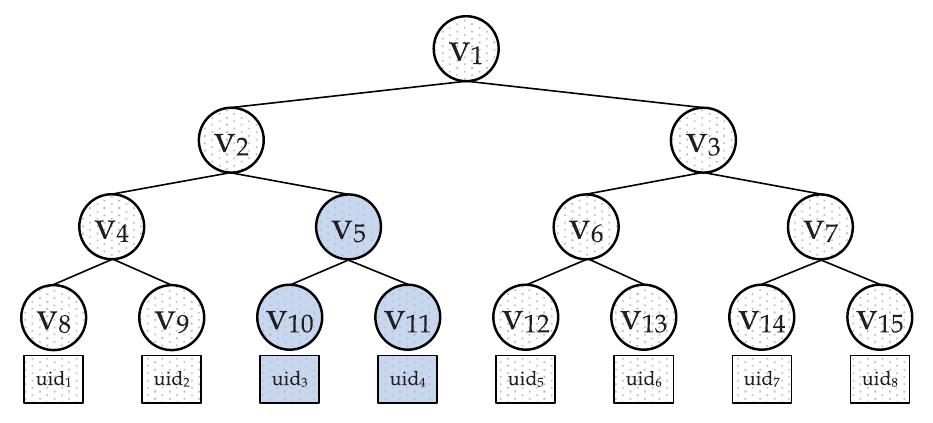
Fig 3. A binary tree to manage attribute group